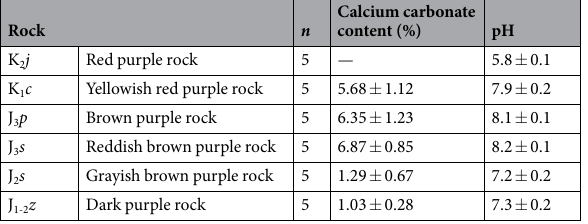
Table 3. Calcium carbonate contents and pH values of the purple rocks.